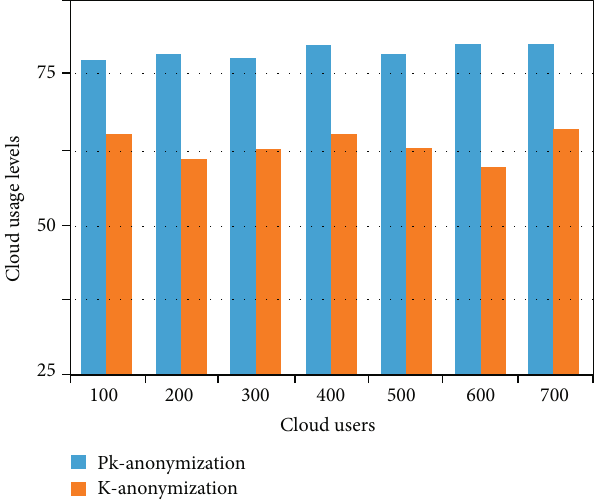
Figure 6: Server usage